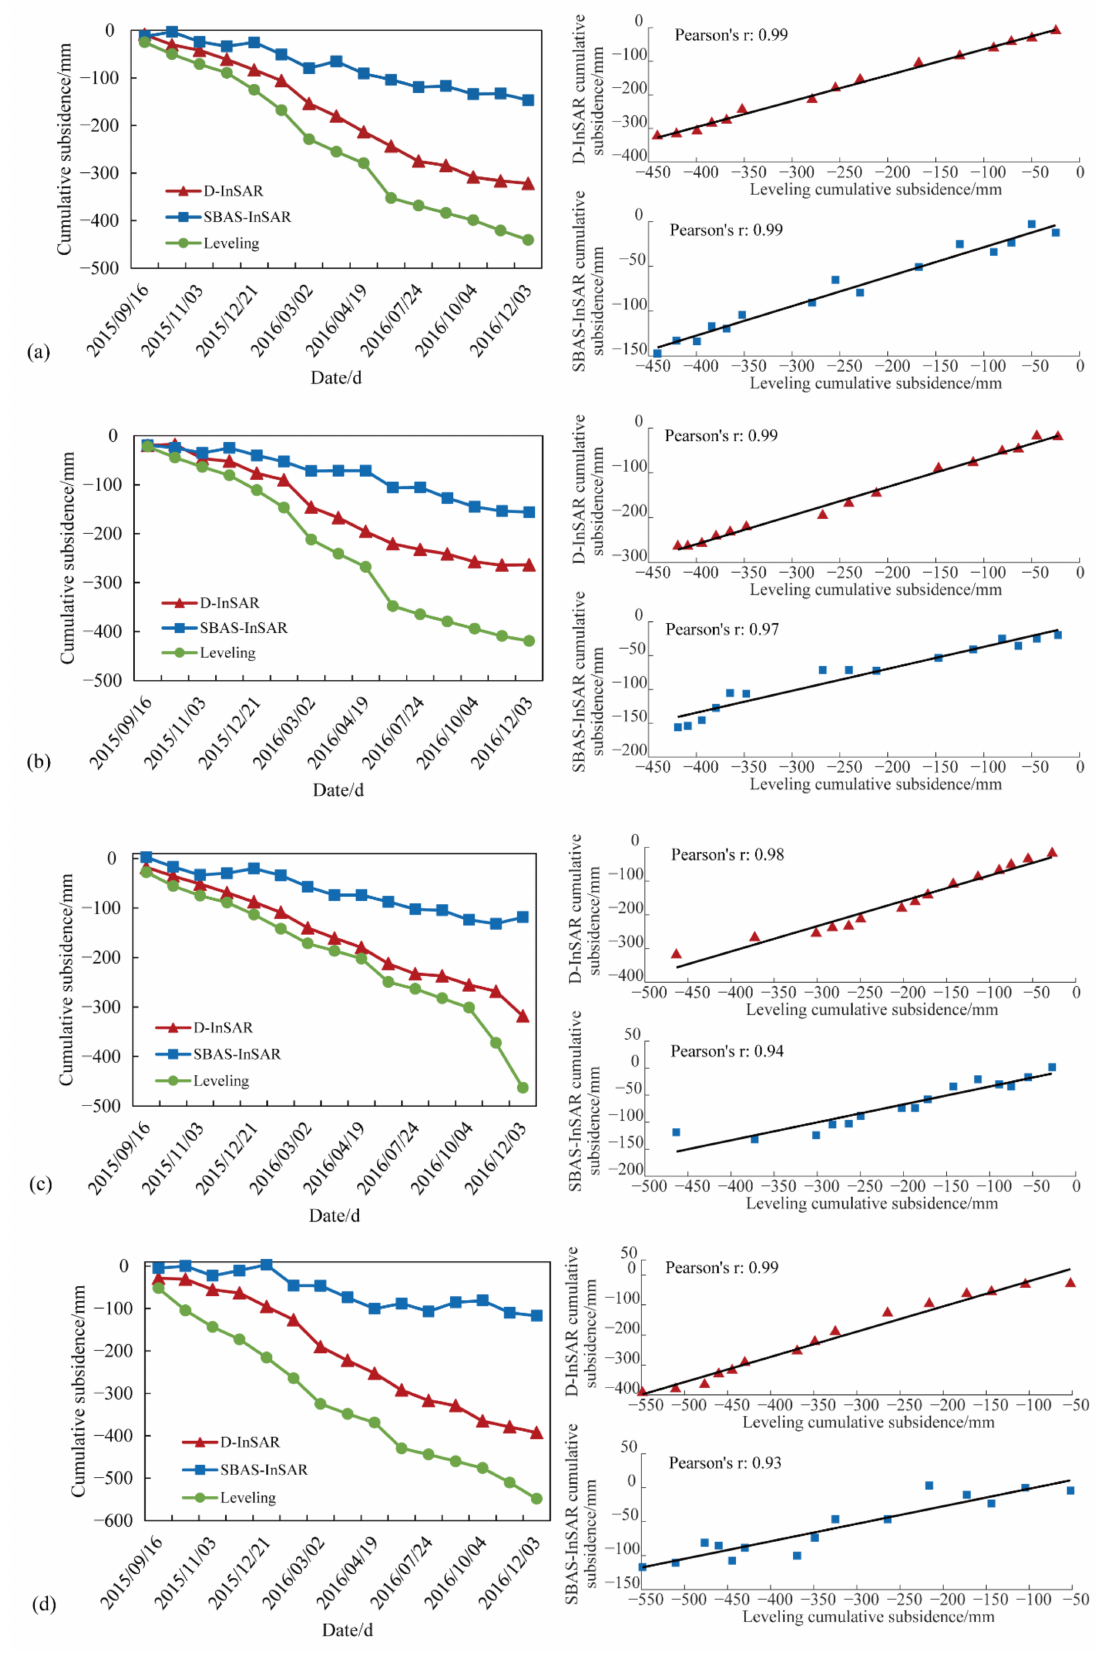
Figure 9. Comparison and correlation coefficients of subsidence curves monitored by D-InSAR, SBAS-InSAR and leveling: ( a ) point H30, ( b ) point H53, ( c ) point Z58 and ( d ) point